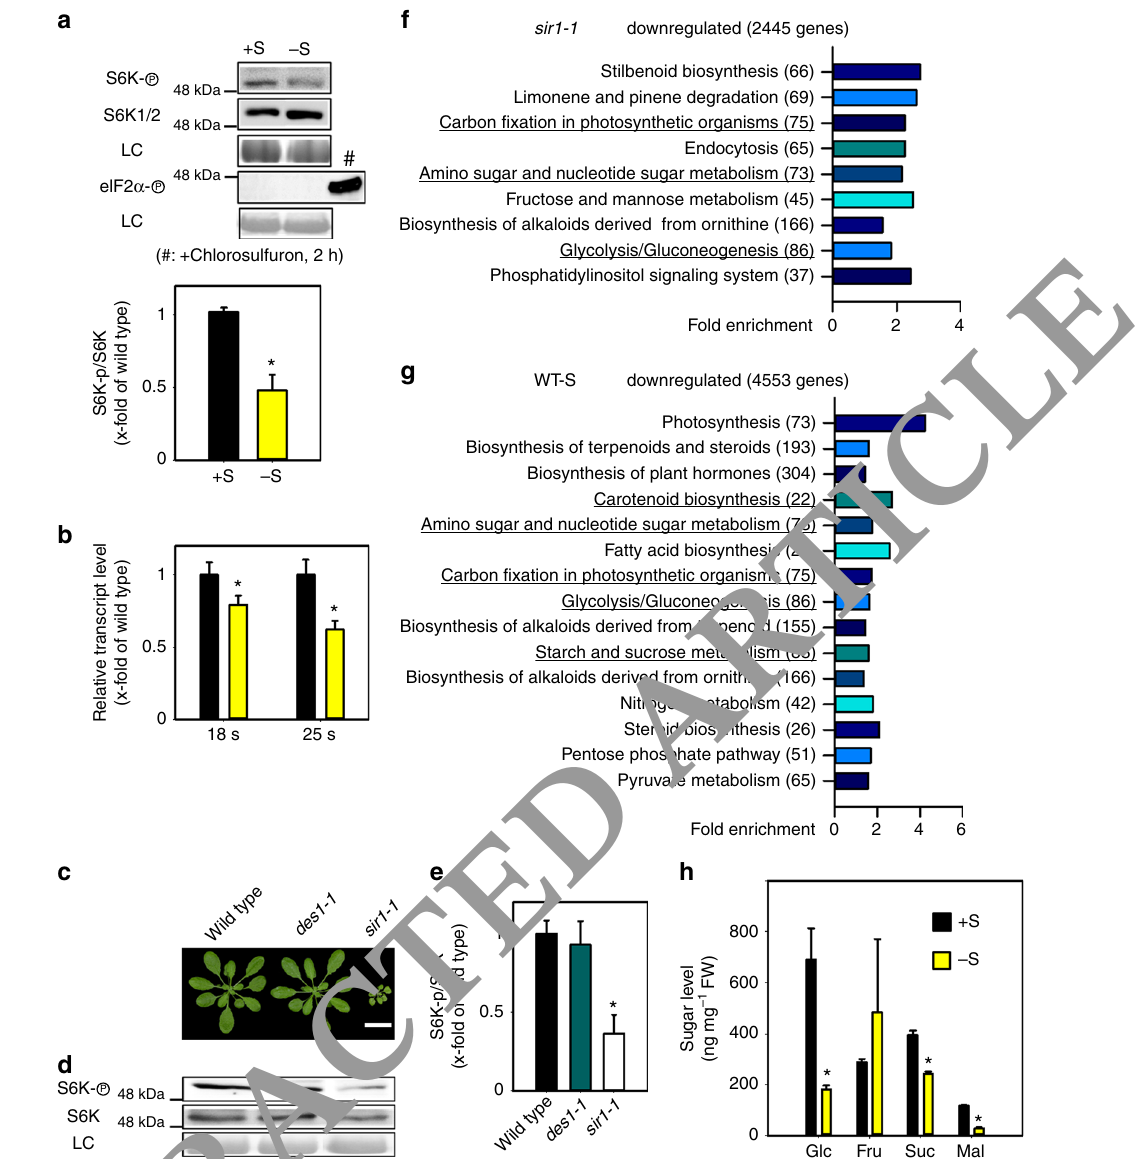
Fig. 3 Sulfur availability downregulates TOR activity and sugar metabolism. a Immunological detection of S6K-p, S6K (52 kDa) and eIF2 α -p (43 kDa) with speci fi c antisera was used for calculation of relative TOR activity by the ratio of S6K-p/S6K in x-fold of wild type ( n = 3, mean ± s.e.m., t -test, * p < 0.05). b 18s and 25s rRNA level were measured in the shoot of wild type under sulfur de fi ciency ( n = 3, mean ± s.e.m., t -test, * p < 0.05). c Growth phenotype of the des1-1 mutant having low sul fi de level in the cytosol. Scale bar, 2 cm. d Immunological detection of S6K phosphorylation status in the genotypes shown in c (apparent sizes of S6K-p, S6K: 52 kDa). e Calculation of TOR activity by the ratio of S6K-p/S6K in x-fold of wild type ( n = 3, mean ± s.e.m., one-way ANOVA, * p < 0.05). f , g Functional category analysis ( p < 0.05, FDR < 0.25) for downregulated genes in shoots of 7-week-old sir1-1 and sulfur-de fi cient WT plants. The compared sets of genes contained transcripts, which were identi fi ed by microarray analysis to be signi fi cantly ( p < 0.05) downregulated by more than 1.25-fold. The categories related to sugar metabolism are highlighted with underlines. h Soluble sugar levels in shoots of 7-week-old sulfur- de fi cient plants ( n = 4, mean ± s.e.m., t -test, * p <